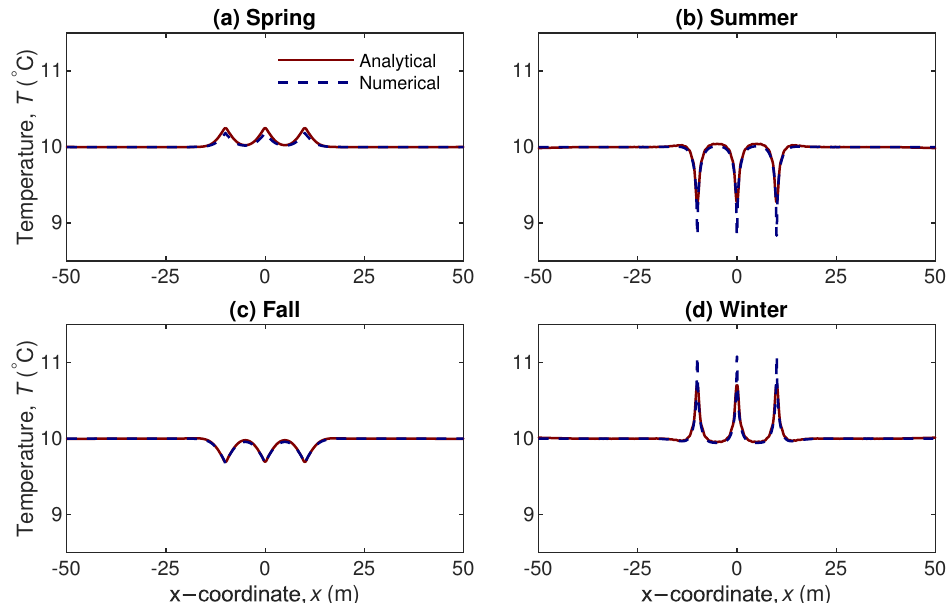
Figure 7. Temperature distribution over the x -coordinate (i.e., the line y = 0) for 3-by-3 boreholes over four seasons: ( a ) Spring ( t = 3 (mon)); ( b ) Summer ( t = 6 (mon)); ( c ) Fall ( t = 9 (mon)); and ( d ) Winter ( t = 12 (mon)). The analytical solution is given by the red solid line and the numerical solution is given by the blue dashed